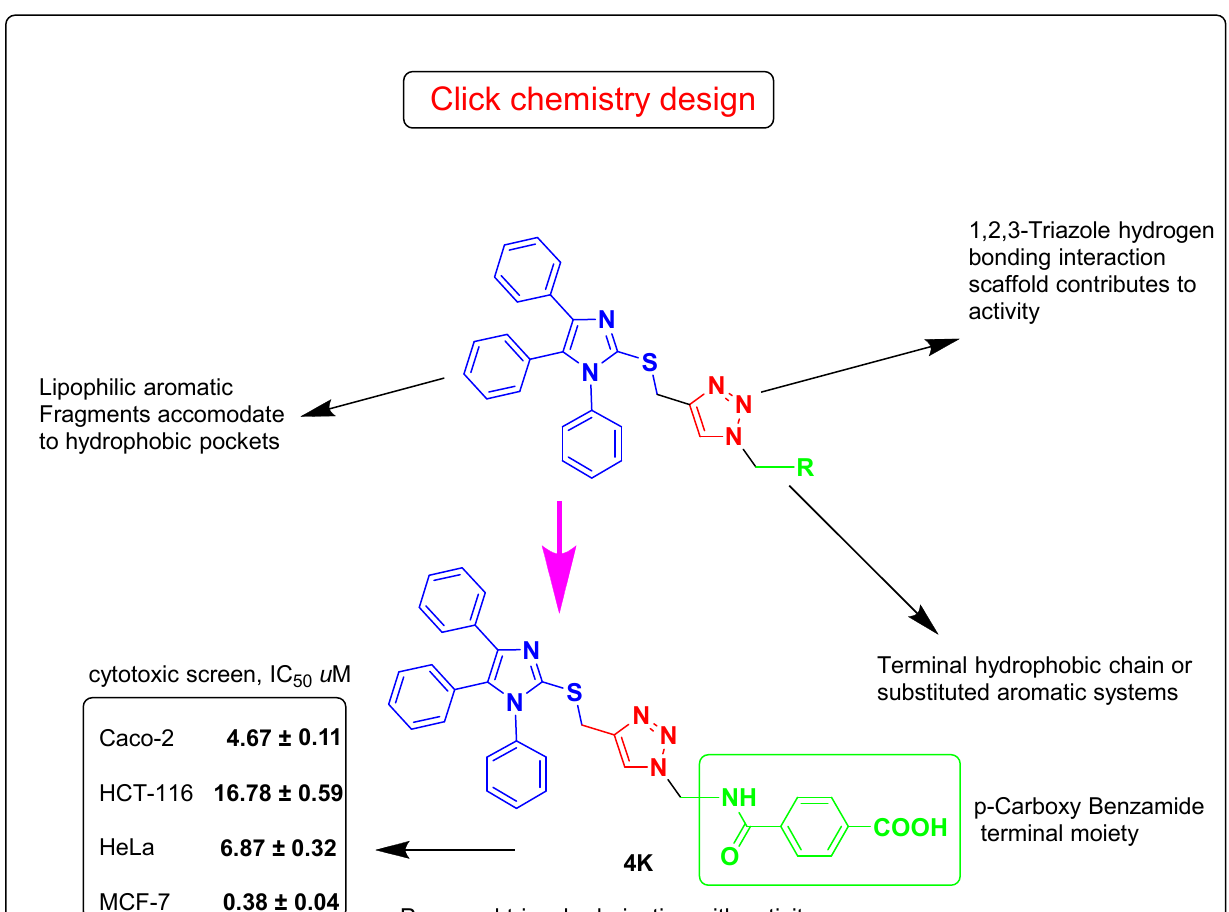
Figure 1. Schematic diagram for the study work.